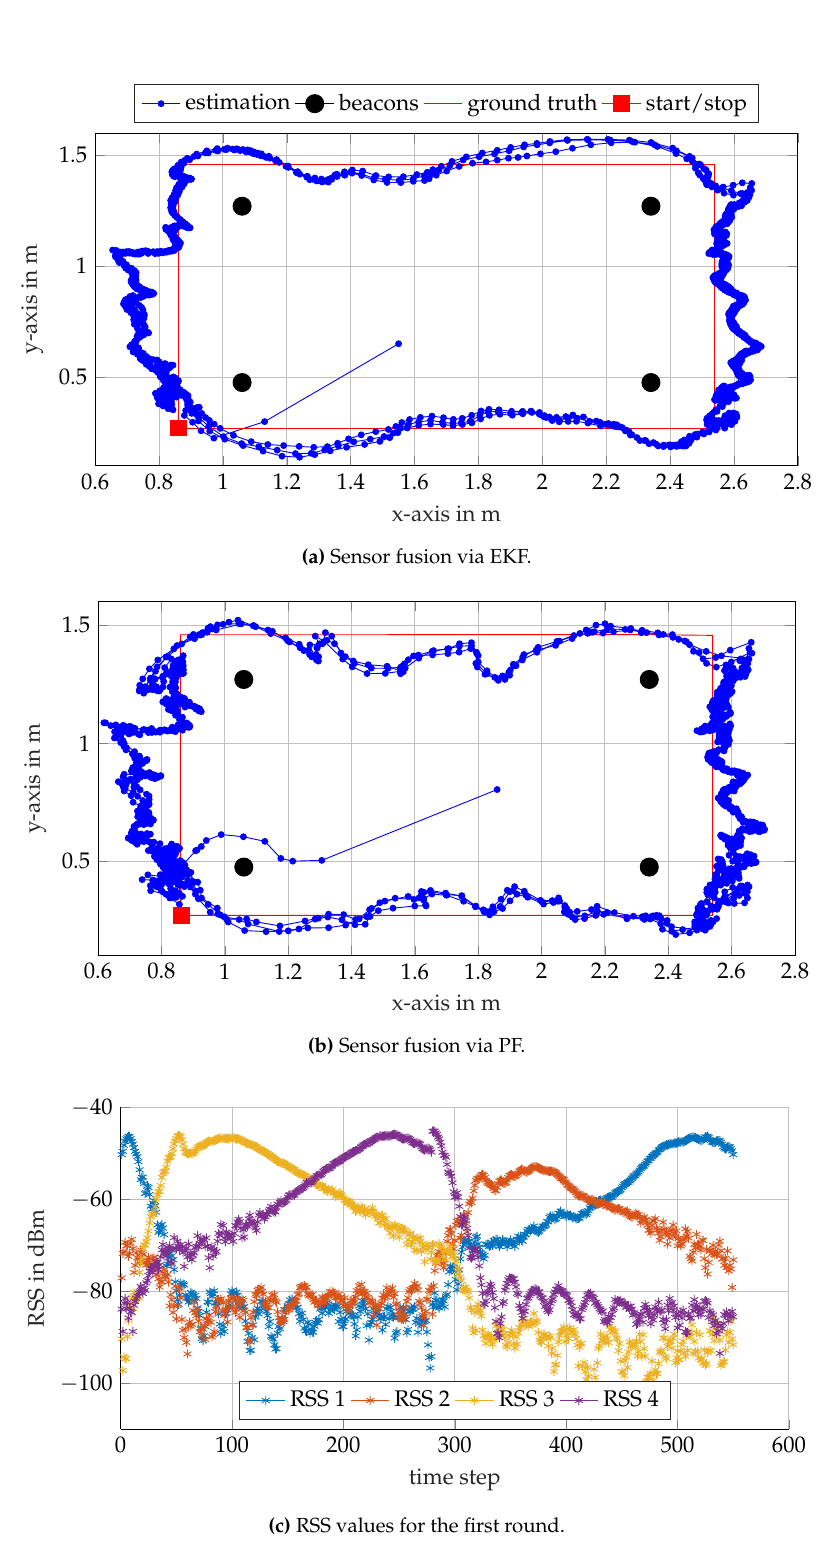
Figure 19. Self-localization results along a rectangular trajectory outside the convex hull of the beacons. The receiver traverses the rectangle three times.